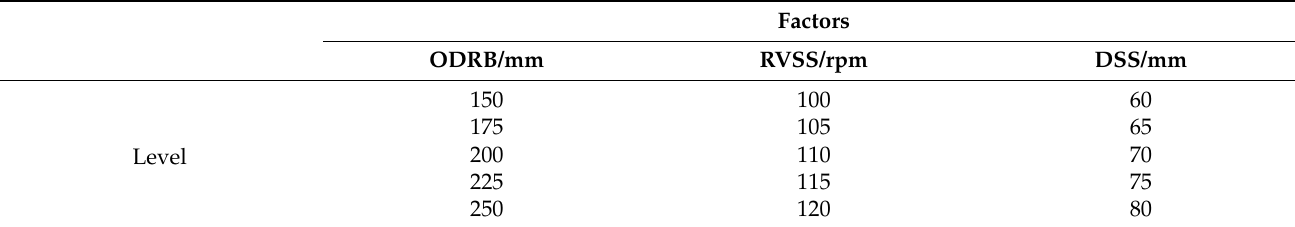
Table 1. Factors and